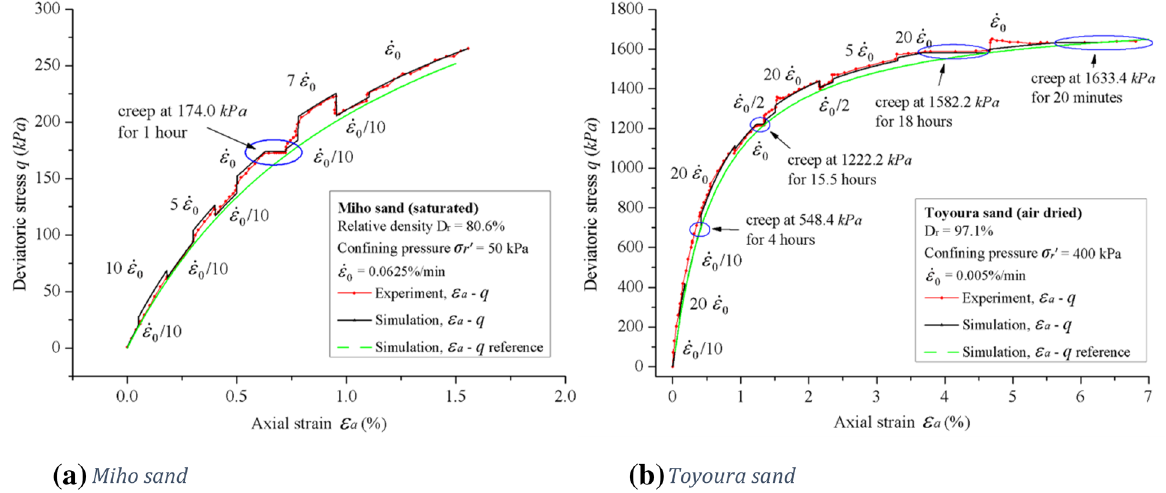
Figure 6. Experimental results of strain-rate controlled triaxial shear experiments by Enomoto et al. ( a Miho sand; b Toyoura